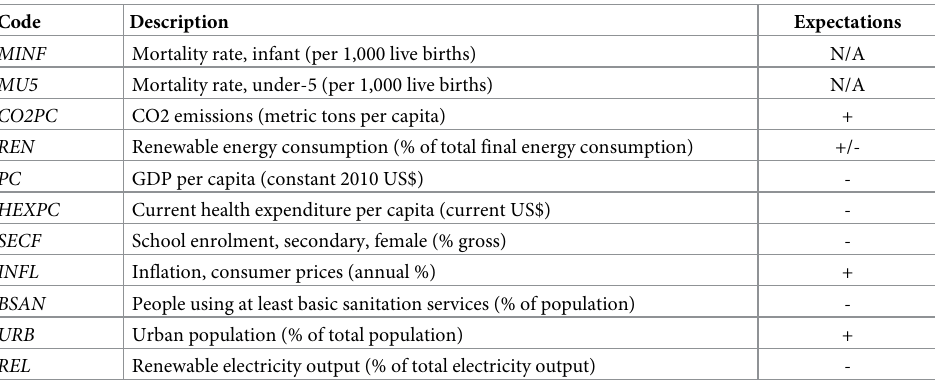
Table 1. Variables description and